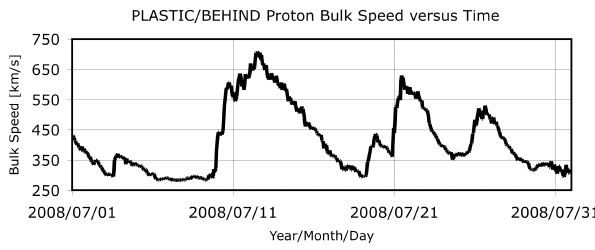
Fig. 2. Solar wind bulk speed measured by PLASTIC/BEHIND in July 2008.